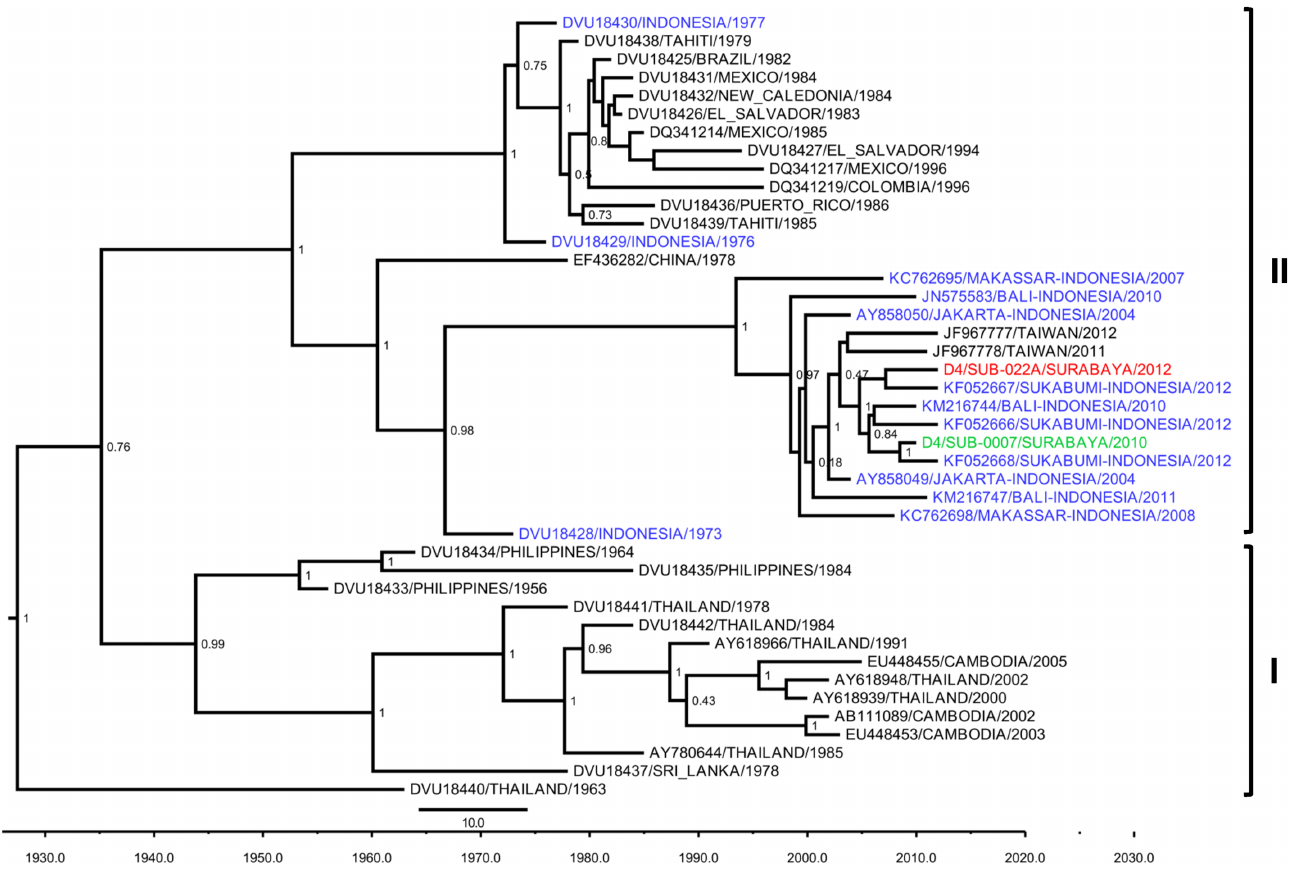
Fig 5. MCC tree of DENV-4 genotype groupings generated by Bayesianinference method as implemented in BEAST using GTR evolution model and gamma parameter rates from the E gene sequences. The Surabaya2012isolate (red font) was groupedinto Genotype II based on classificationby Lanciotti et al [30], together with isolates from Surabaya 2010 (green font) and other cities in Indonesia(blue font). The posterior probabilities of the clades are indicatedas numbersin the node labels.